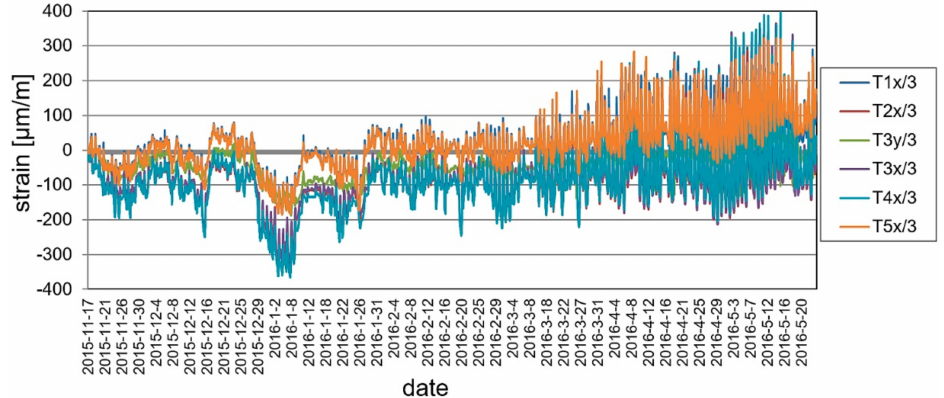
Figure 25. Strain monitoring using VWSG sensors during a six month monitoring